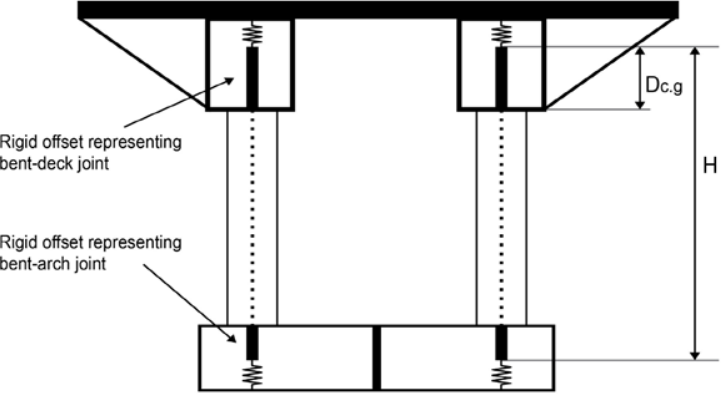
Figure 6. Pier end locations relative to the top and bottom joints [18].